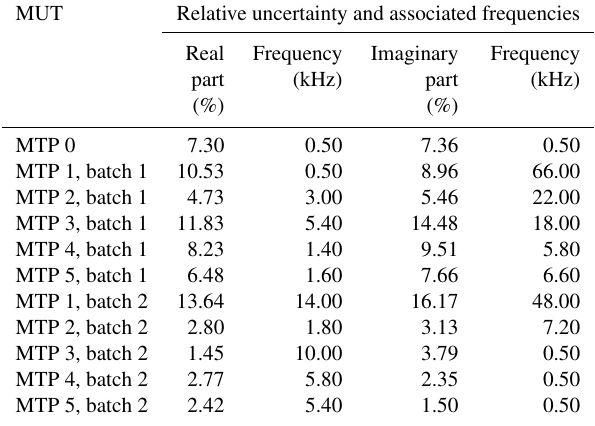
Table 5. Relative uncertainties in the real and imaginary parts of the field-measured MUT impedances at various regeneration states and the associated frequencies, at a confidence level of